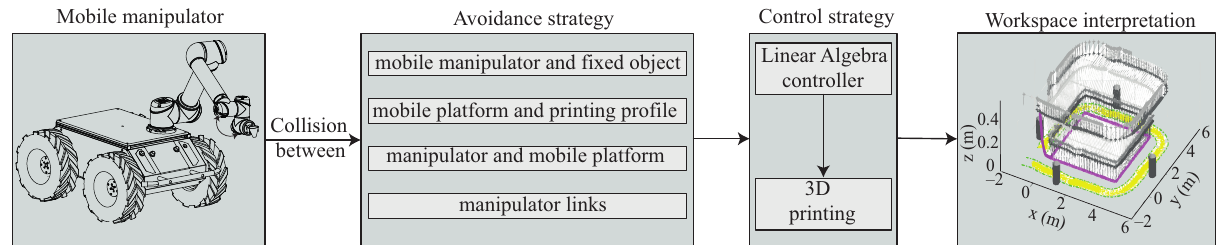
Figure 2. Workspace analysis of a mobile manipulator in 3D printing task.